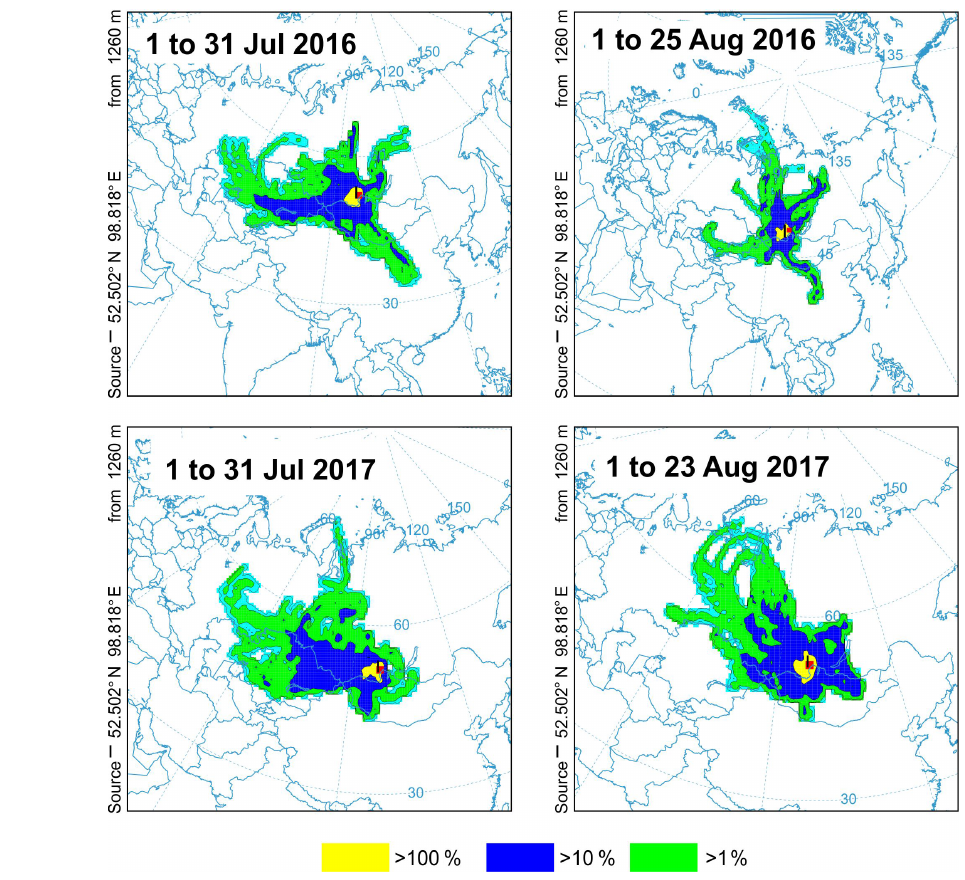
Figure 5. Frequency maps of 5d backward trajectories for July and August of 2016–2017 (days with precipitation).